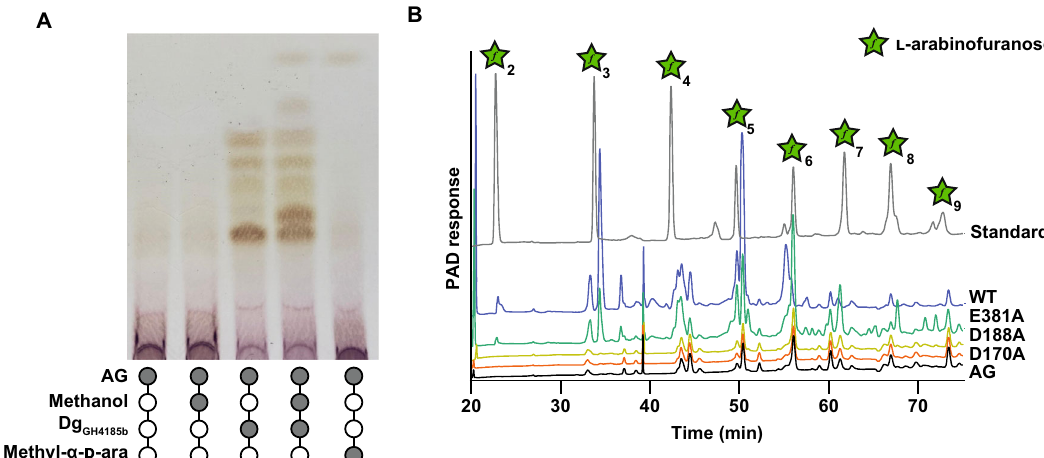
Fig. 5 | Catalytic analysis of DUF4185 endo- D -arabinofuranases. A Methanolysis of AG catalyzed by Dg GH4185b . The production of methyl arabinosides in the pre- sence of methanol indicates a retaining mechanism. B Dg GH4185b -WT, Dg GH4185b - D149A and Dg GH4185b -D167A were incubated at 1 µ M with 2mgml -1 AG for 16hours